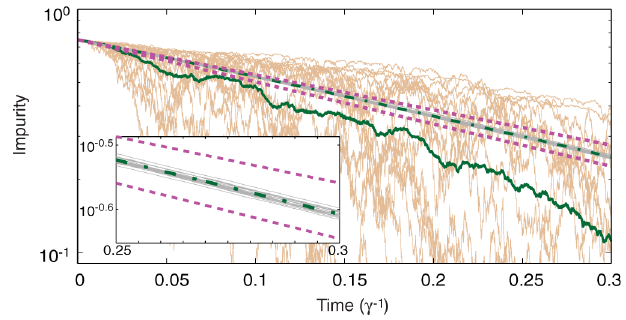
FIG. 7. A comparison between the complementary- measurement protocol and RM feedback (of Ref. [5]) for D ¼ 4 , (cid:7)t ¼ 10 (cid:2) 4 (cid:2) (cid:2) 1 , and an ensemble of 20 trajectories in each case. The dashed lines are the analytically calculated bounds on dL for complementary feedback [Eqs. (27) and (30)]. The dash-dotted green line (inset) is the ensemble average for L with the QFT feedback. The solid dark green line is the ensemble average for the RM feedback. The light brown lines are the trajectories for the RM feedback. The analytical bounds suggest that both feedback strategies have the same order of speeding-up. Inset: All of the complementary-measurement trajectories (gray lines) lie within the predicted bounds. The trajectories are very nearly